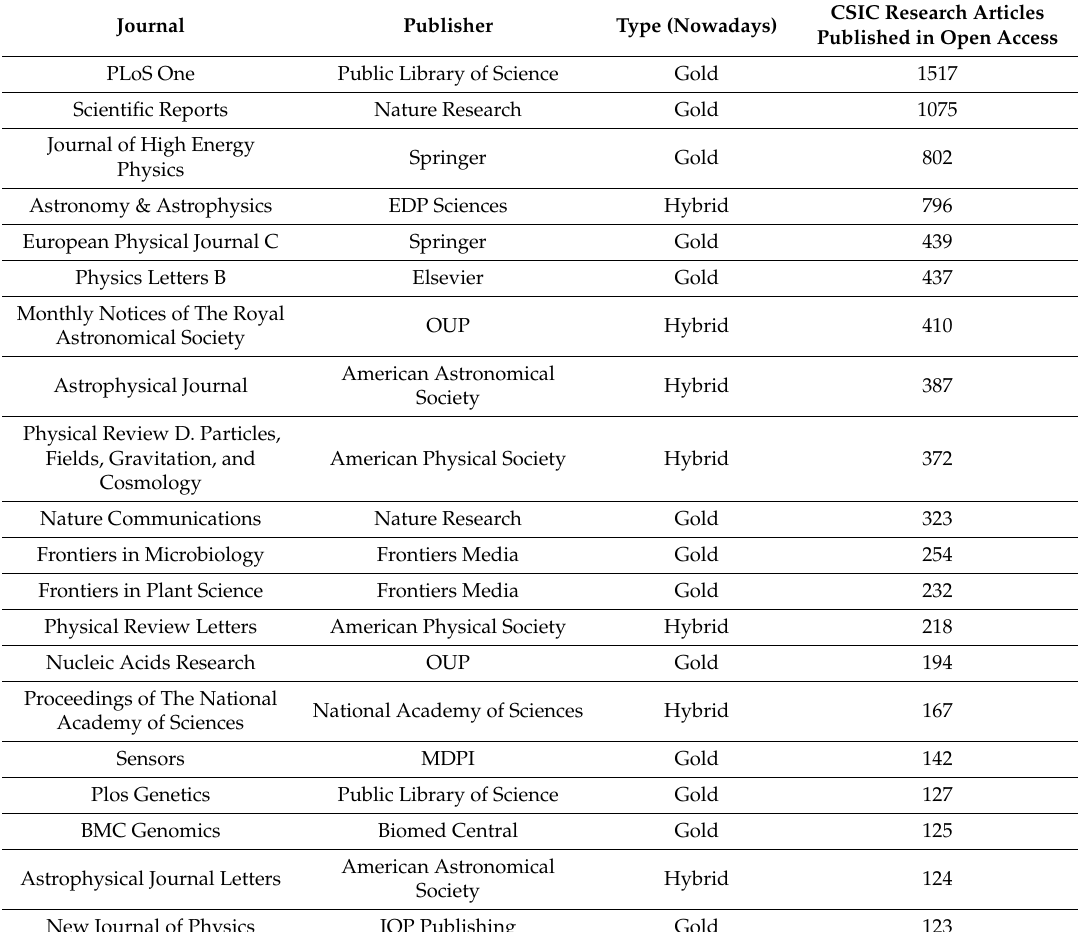
Figure 7. Graph of the evolution of CSIC publishing in Gold and Hybrid Journals in 2008–2018. Table 4. TOP20 Journals with CSIC Research Articles in Open Access,